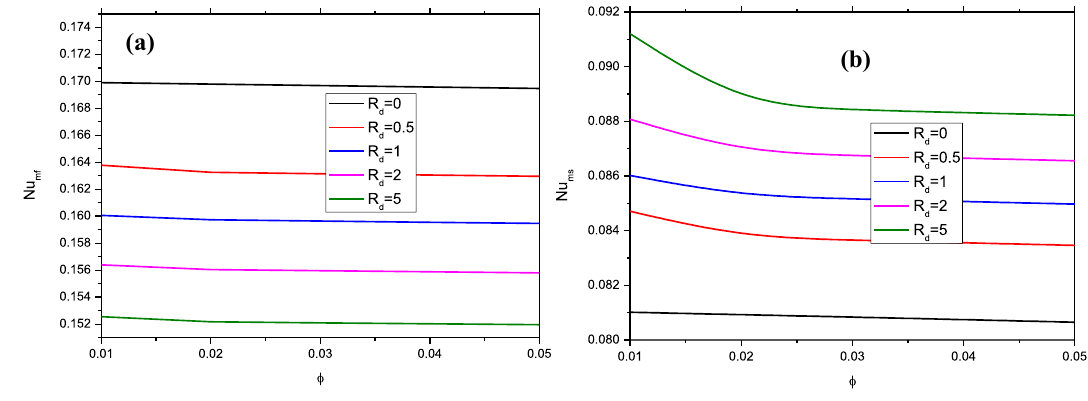
Fig. 11 Radiation heat transfer parameter profiles of the average Nusselt number of fluid phase (a) and solid phase (b) for TiO nanofluid at Ha = 10 , Q = 1 , Da = 10 – 3 , Ri = 1 , Gr